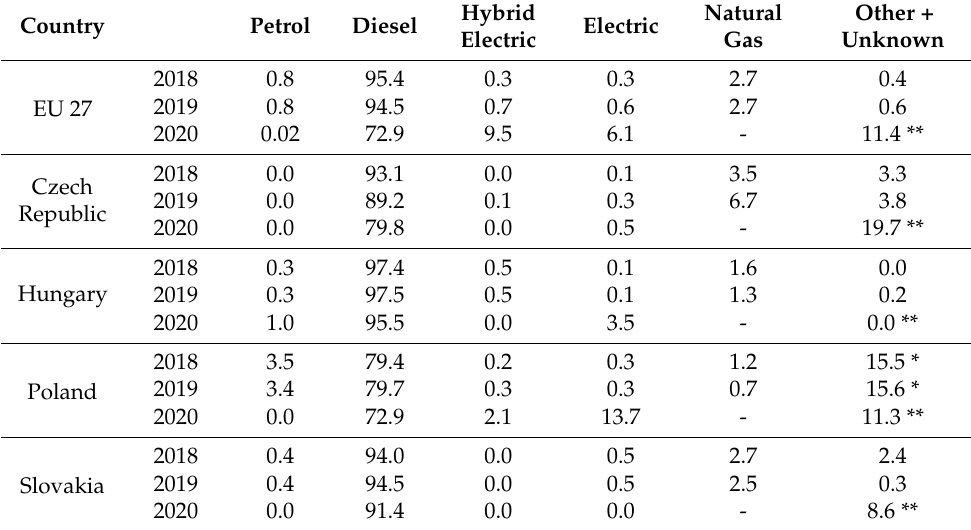
Table 3. Newly registered buses and coaches in the V4 and EU countries, by type of